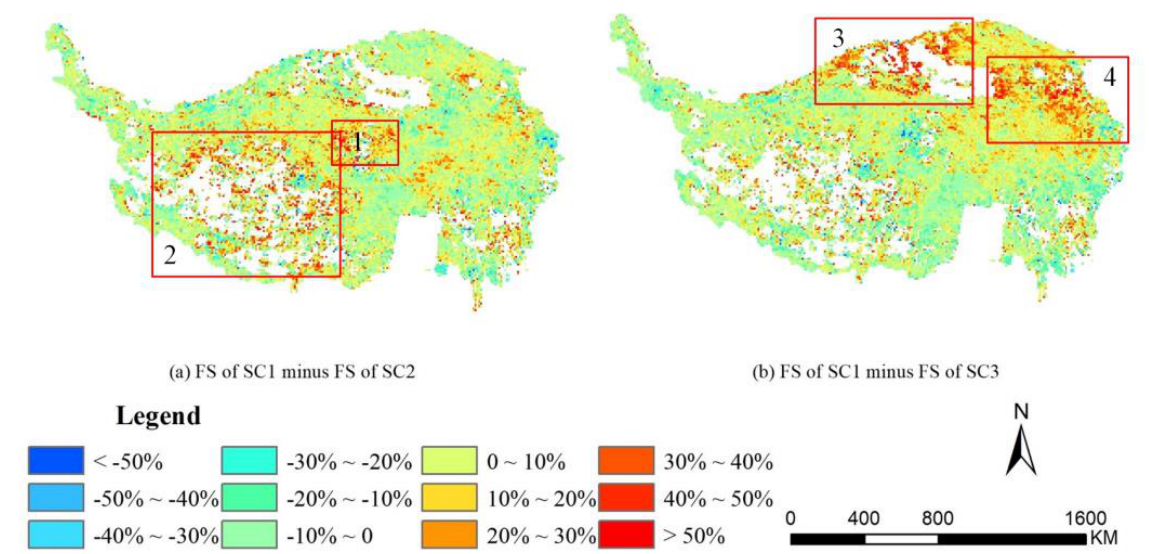
Figure 4. Spatial distribution of F1-score (FS) differences for cloud-gap-filled snow cover at the resolution of 10 × 10 km. SC1, SC2, and SC3 were the snow cover products of the combined MOD10A1F and MYD10A1F (SC1) developed by Huang et al. [28] and Qiu et al. [29], respectively.